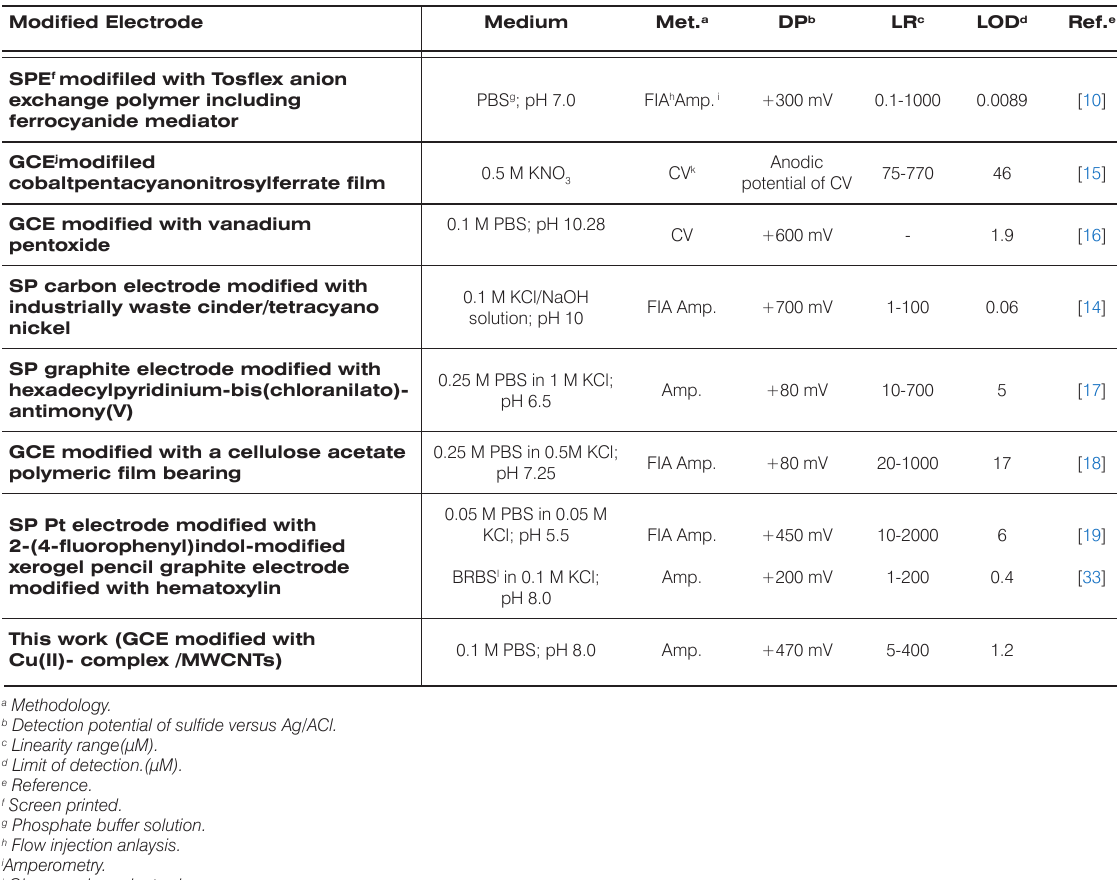
Figure 10. Amperometric response at a rotating modified Cu- complex/MWCNT/GCE for successive addition of 100- 900.0 μM total sulfide. Inset: plot of chronoamperometric current response vs. total sulfide concentration. Other conditions were as used in Fig. 9. Table 1. Analytical parameters for detection sulfide at several modified